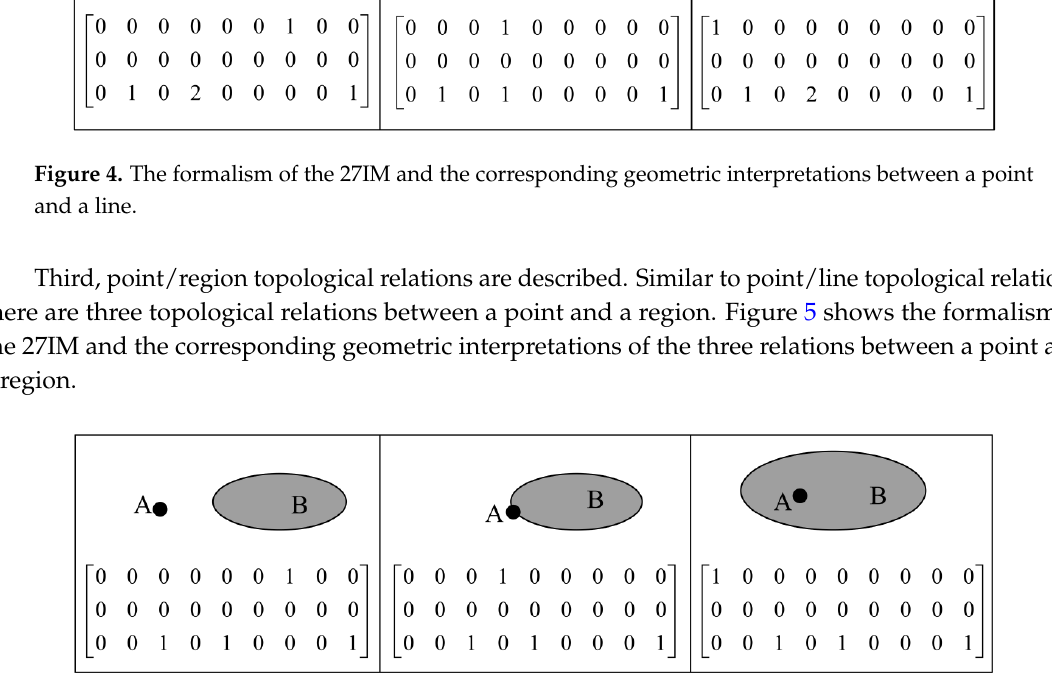
Figure 6. The formalism of the 27IM and corresponding geometric interpretations between two lines. Fifth, line/region topological relations are described. Considering dimensions and the number of separations (for example, the number of intersections between the interior of a line and the boundary of a region, the number of intersections between the interior of a line and the interior of a region and the number of intersections between the interior of a line and the exterior of a region may be infinite), there are countless topological relations between a line and a region; therefore, it is impossible to express all of the possible topological relations. Instead, Figure 7 shows the formalism of the 27IM and the corresponding geometric interpretations of nine typical relations between a line and a region.